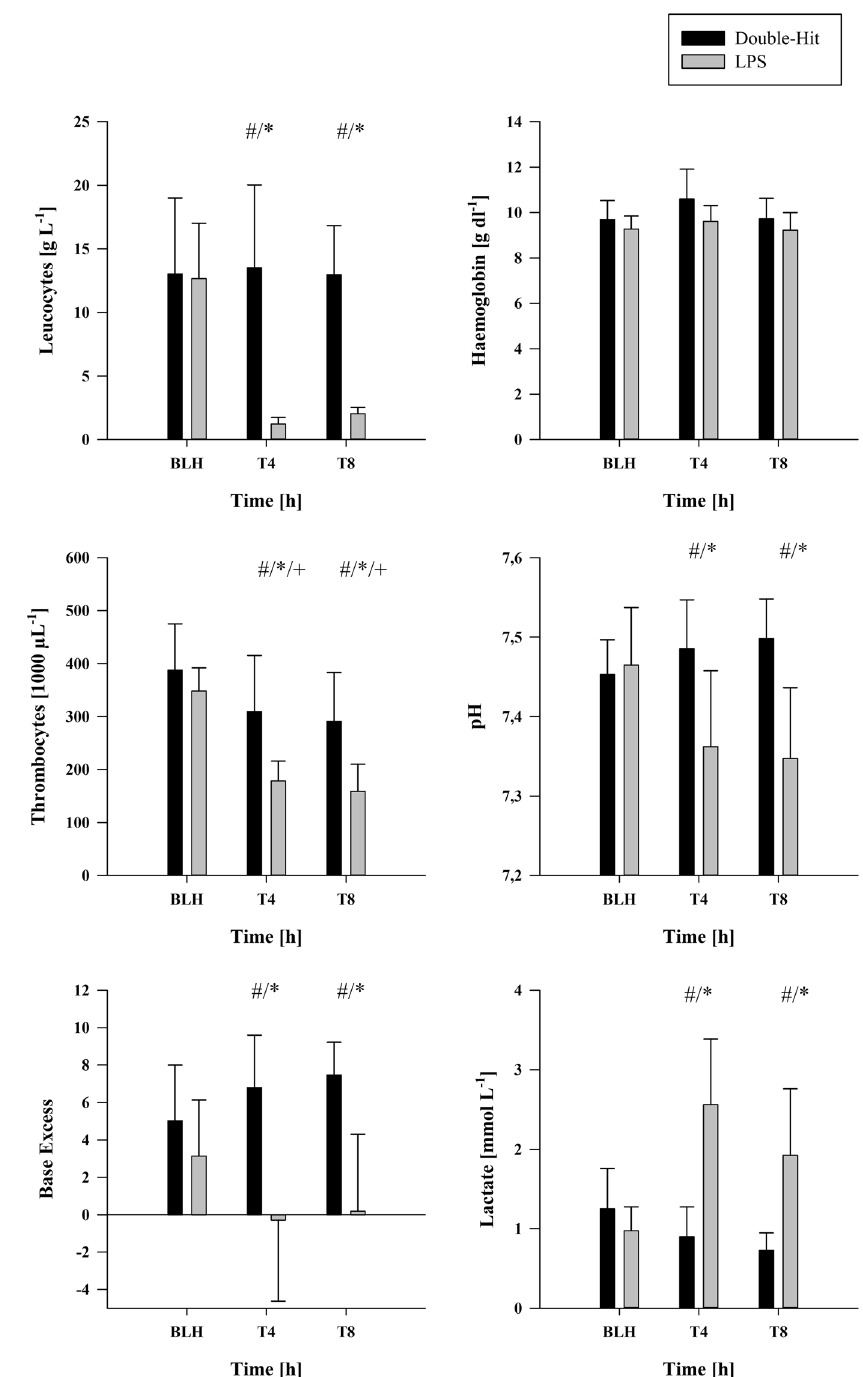
.94 vs. 11.24 0.82; T0/T4/T8 vs. BLH for double-hit; 14.89 ± 11.63 2.28; T4/T8 vs. BLH for LPS; both p < 0.05; Table 1). In the LPS group, statis- ± tically higher doses of norepinephrine were used compared to the double-hit